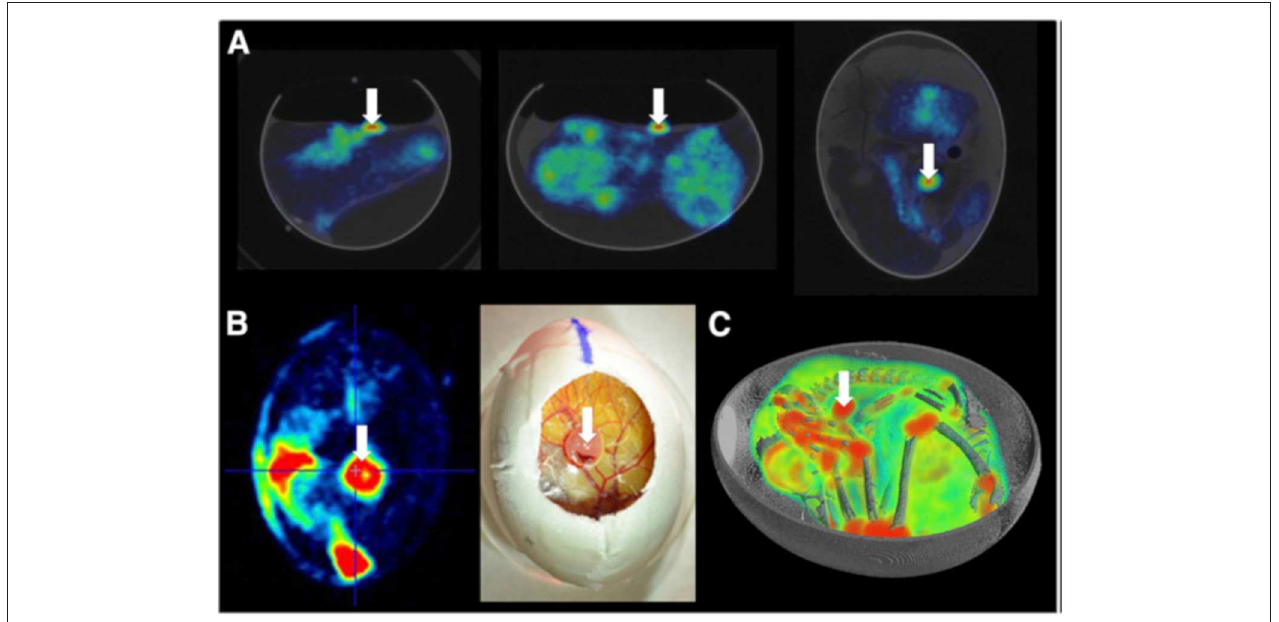
FIGURE 9 | (A) Two-dimensional coregistered PET and CT images of the chicken egg after [ 18 F]-FDG injection and 45min tracer uptake. (B) Visual comparison of 18F-FDG uptake in glioblastoma at level of CAM to photograph illustrating tumor localization. (C) 3D visualization of overlaid PET and CT images for [ 18 F]-FDG uptake in embryo and U87 human glioblastoma tumor (white arrow). This research was originally published in JNM: in vivo PET/CT in a human glioblastoma chicken chorioallantoic membrane model: a new tool for oncology and radiotracer development. Warnock et al. © by the Society of Nuclear Medicine and Molecular Imaging, Inc.